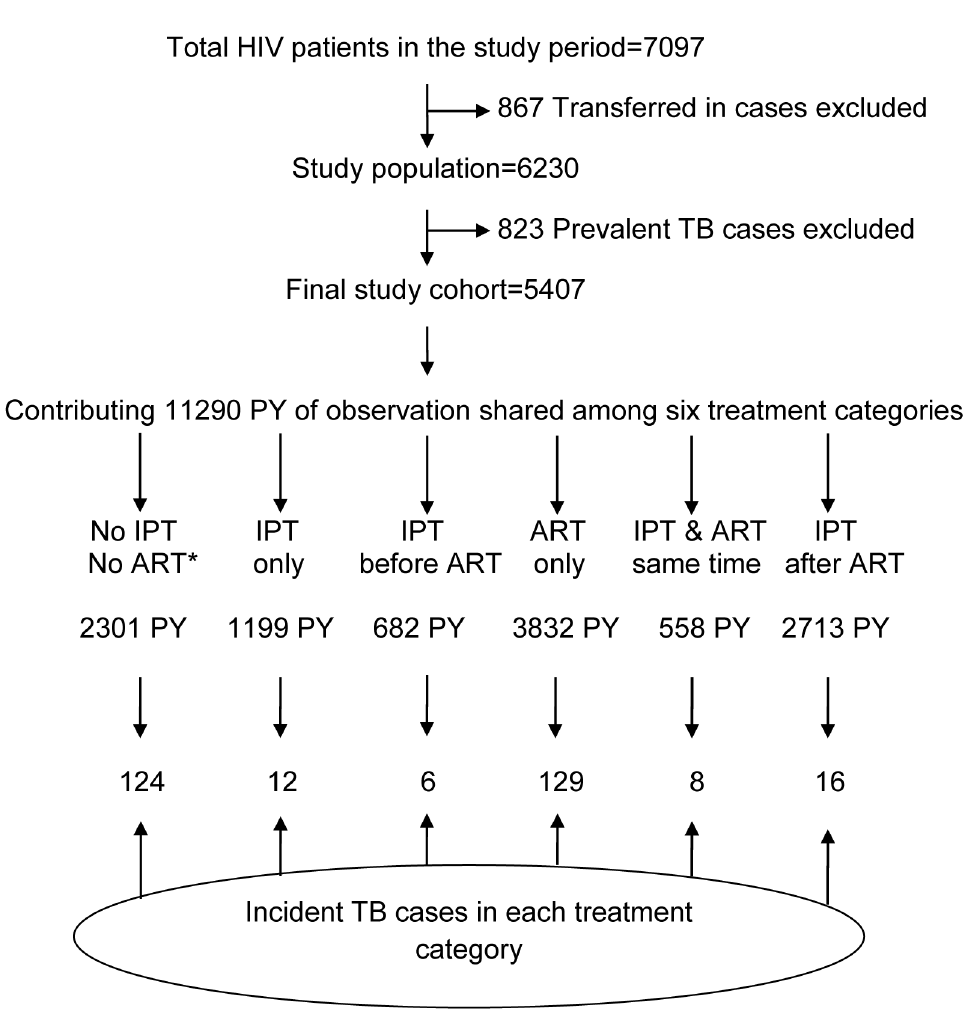
Figure 1. Cohort profile of study population, SNNP region, Ethiopia, September 2007 to August 2010. Of 7,097 patients enrolled in chronic HIV care, 5,407 were eligible for analysis contributing a total of 11,290 PY of follow-up. These were further classified into six treatment categories based on the combination of treatment received, IPT and/or ART, as well as the timing of IPT initiation with respect to ART. There were 295 incident TB cases diagnosed in the study period. IPT-Isoniazid Preventive Therapy; ART-antiretroviral therapy; TB-Tuberculosis; HIV-Human Immunodeficiency virus; PY-person year. * ‘No IPT NO ART’ group is equivalent to no intervention group.